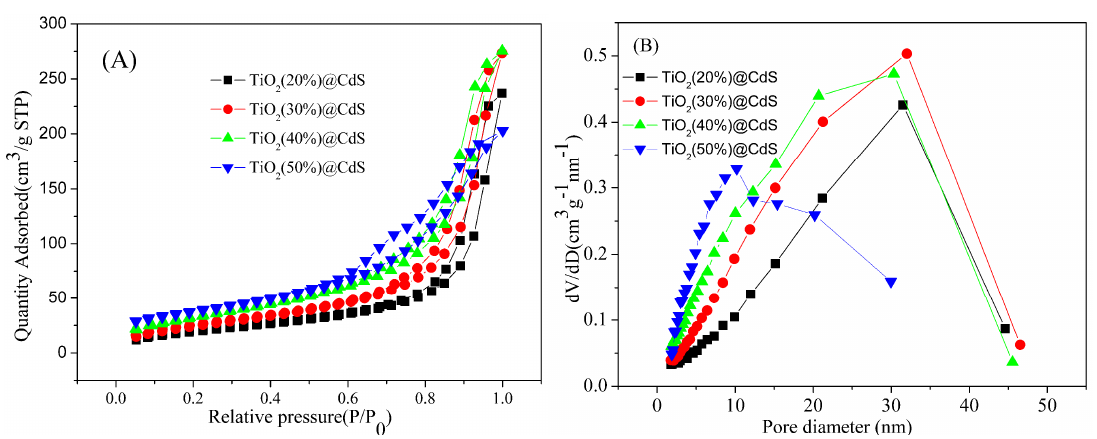
Figure 7. N 2 adsorption–desorption isothermal graphs ( A ) and pore size distribution ( B ) of TiO 2 (20%)@CdS,TiO 2 (30%)@CdS, TiO 2 (40%)@CdS, and TiO 2 (50%)@CdS composites. Table 1. Specific surface are and pore volume of the